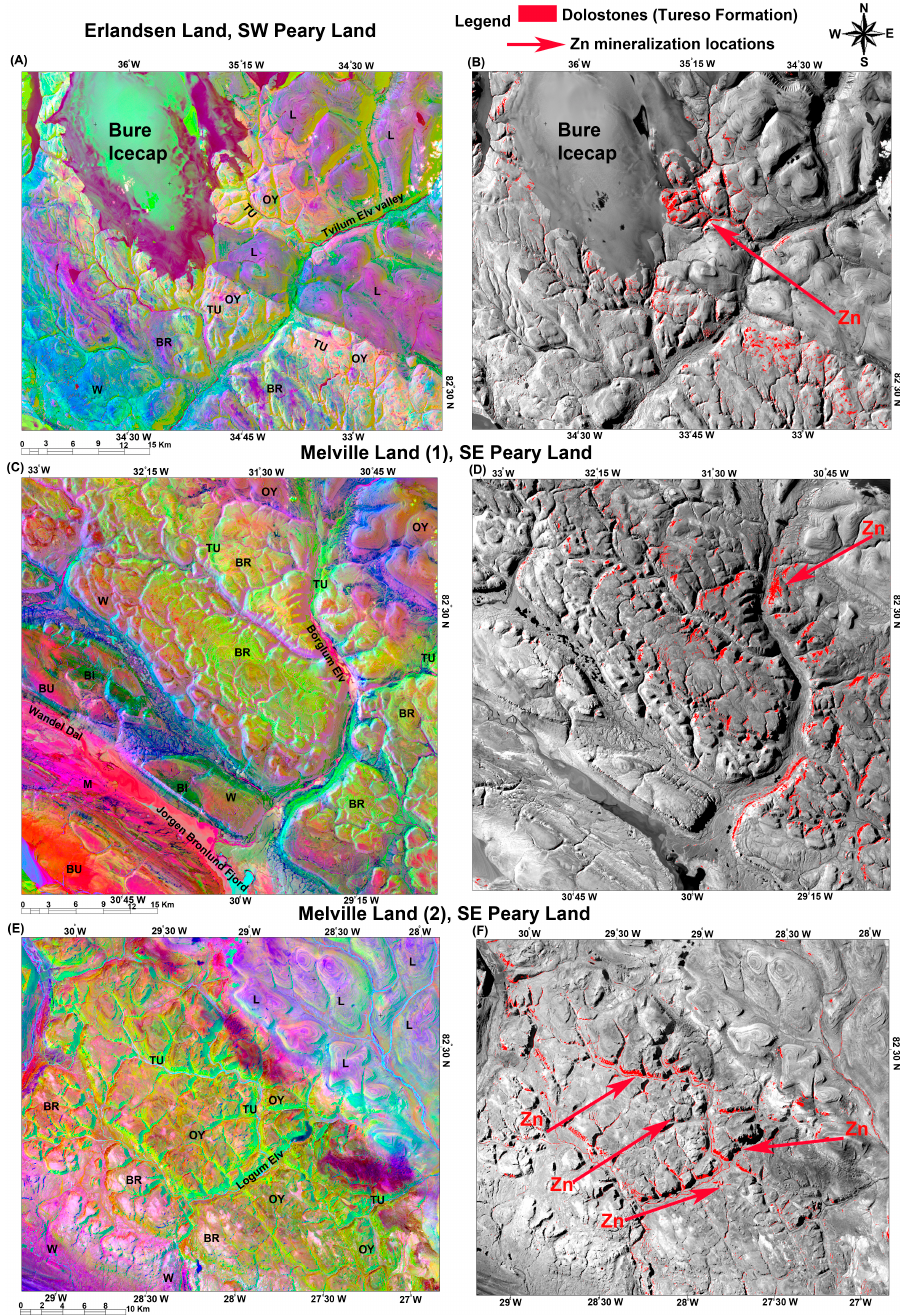
Figure 8. ICA image maps of Landsat-8 spatial subset scenes considered for MVT Zn–Pb mineralization. ( A ) RGB image map of ICA5, ICA4 and ICA3 for the subset of the Erlandsen Land, SW Peary Land; ( B ) ICA3 image showing dolostones (Tureso Formation) for the subset of the Erlandsen Land, SW Peary Land; ( C ) RGB image map of ICA5, ICA4 and ICA3 for the subset of the Melville Land (1), SE Peary Land; ( D ) ICA3 image showing dolostones (Tureso Formation) for the subset of the Melville Land (1), SE Peary Land; ( E ) RGB image map of ICA5, ICA4 and ICA3 for the subset of the Melville Land (2), SE Peary Land; ( F ) ICA3 image showing dolostones (Tureso Formation) for the Melville Land (2), SE Peary Land. Lithostratigraphic units are abbreviated as TU = Tureso Formation, OY = Odins Fjord and Ymers Gletcher Formations, L = Lauge Koch Land Formation, BI = Bistrup and Bronlund Formations, BR = Børglum River Formation, BU = Buen Formation, M = Merqujoq Formation, and W = Wulff Land Formation. Zn mineralization localities point by red arrows.